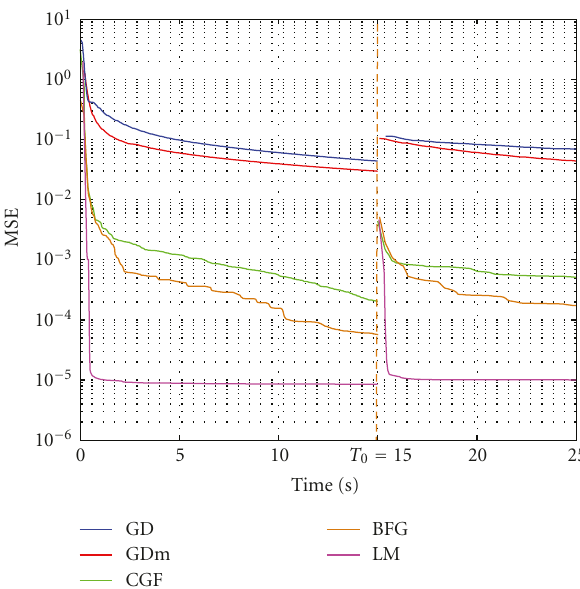
Figure 19: Mean square error versus